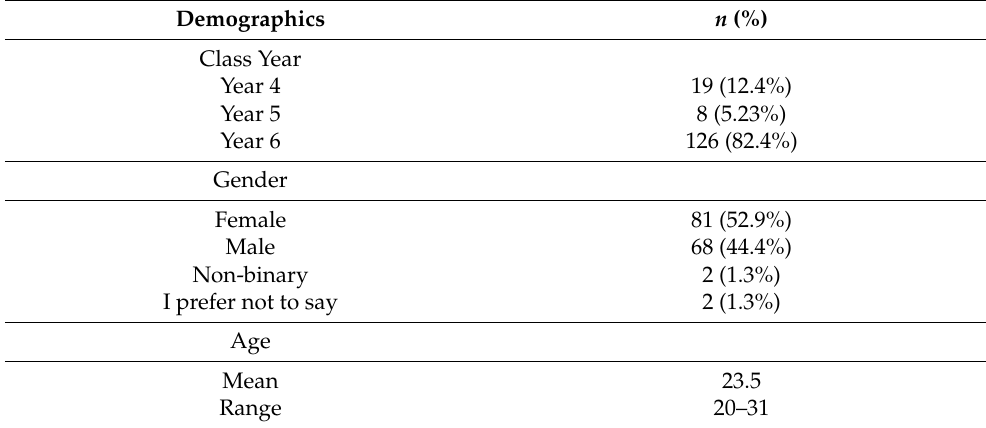
Table 3. Demographic characteristics of survey